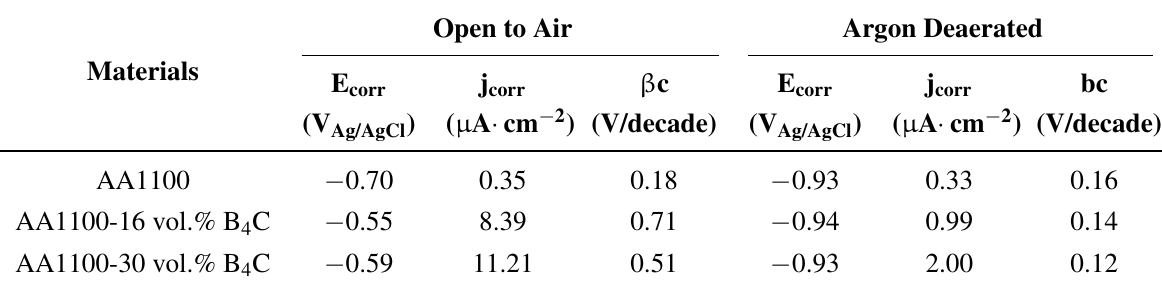
Figure 3. ( a ) Potentiodynamic polarization curve recorded on AA1100, AA1100-16 vol.% B 4 C and AA1100-30 vol.% B 4 C in 3.5 wt.% NaCl in open to air condition; ( b ) Plot showing the j corr was obtained at the intersection point of extrapolation of the cathodic polarization branch and the E corr horizontal line. Table 2. Electrochemical parameters derived from polarization curves. Table 2. Electrochemical parameters derived from polarization